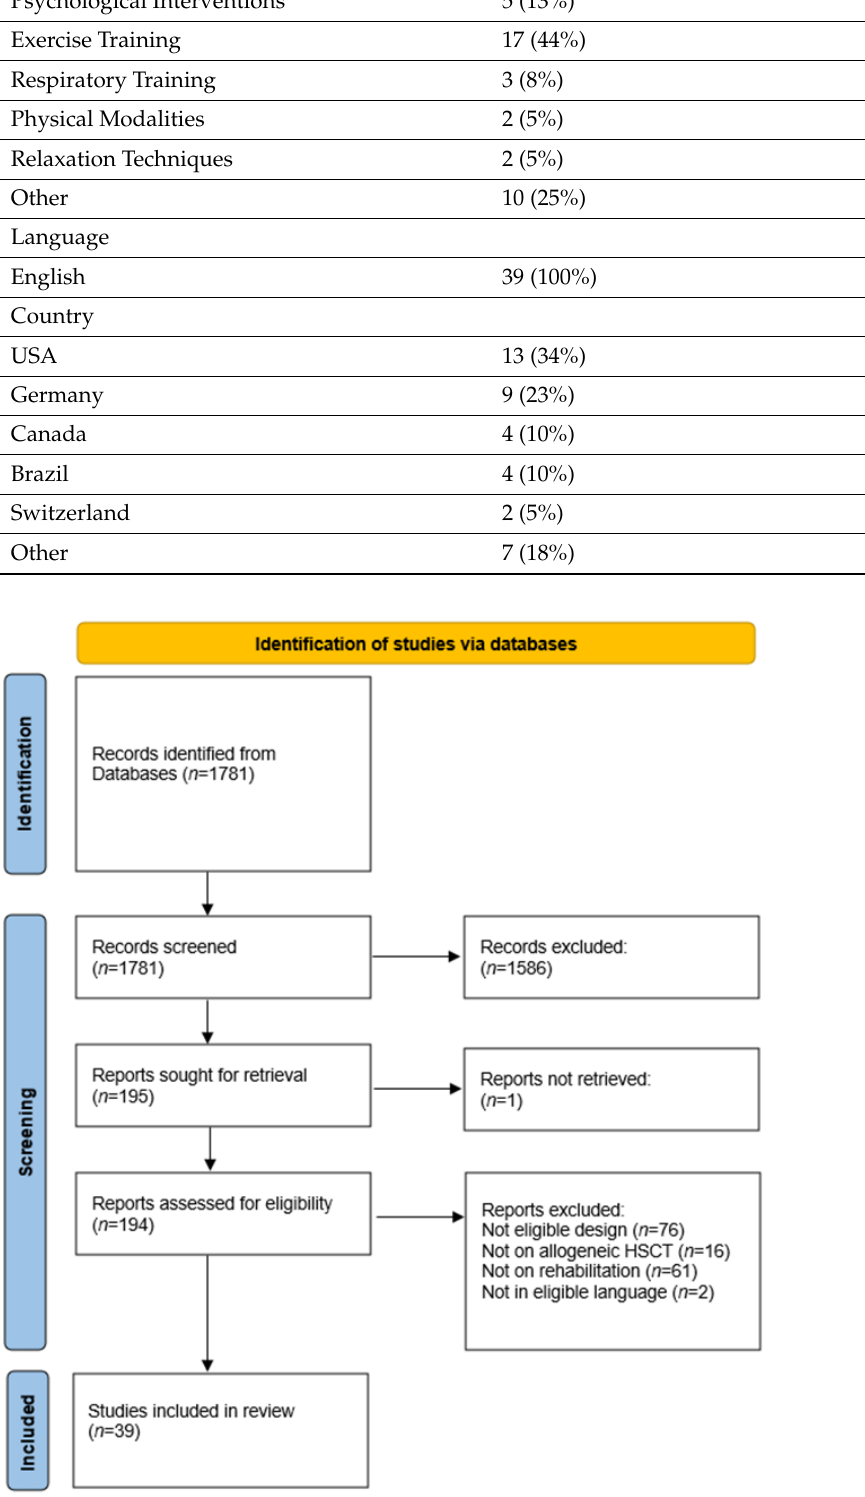
Figure 1. Study selection flowchart.